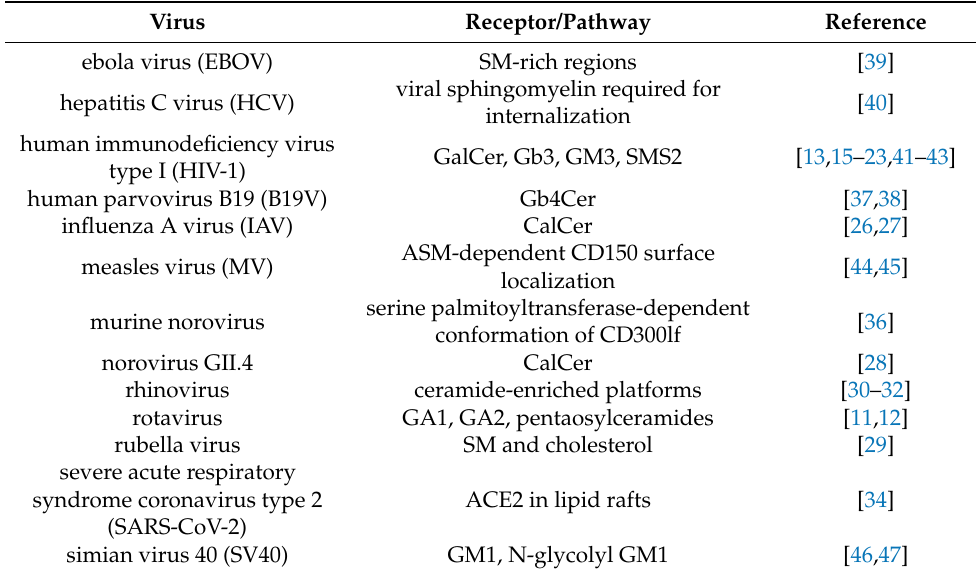
Table 1. Viruses using sphingolipids for cell